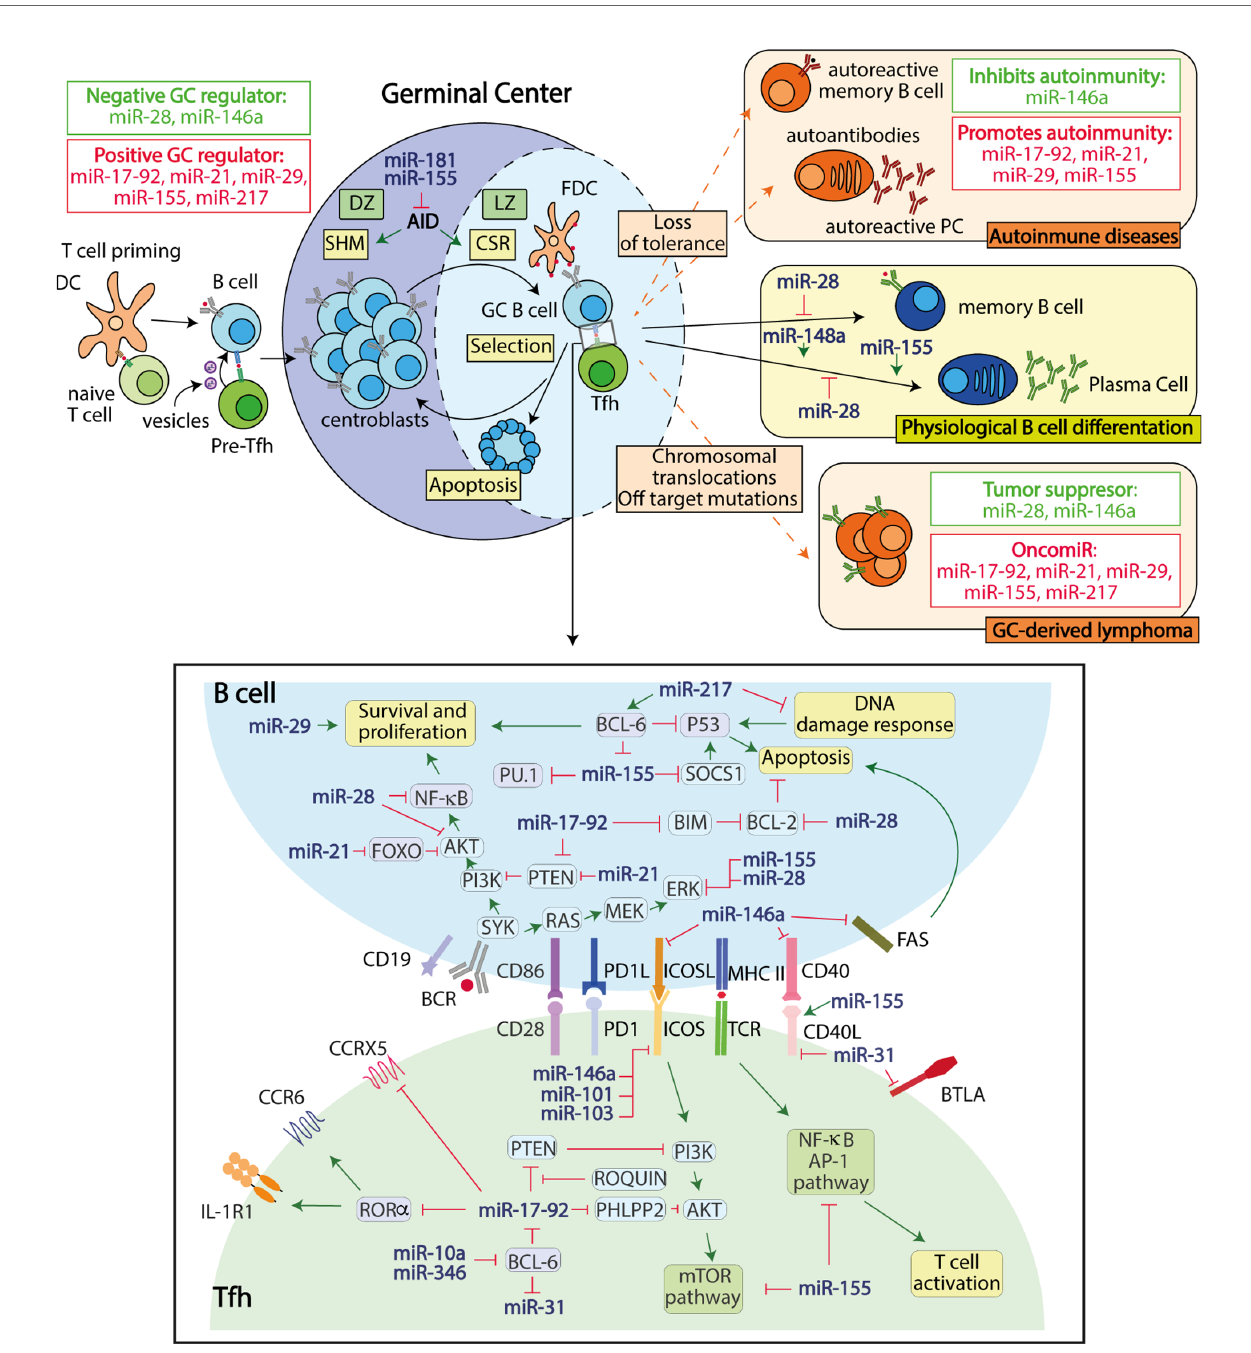
FIGURE 1 | miRNAs regulate gene expression in B and Tfh germinal center cells. Regulated miRNA expression is required to regulate B-Tfh cell interactions and ensure proper GC responses. GC-derived dysfunctions caused by miRNA alterations can lead to the development of autoimmunity and/or B cell neoplasia through the disruption of post-transcriptional control mechanisms required for the maintenance of GC